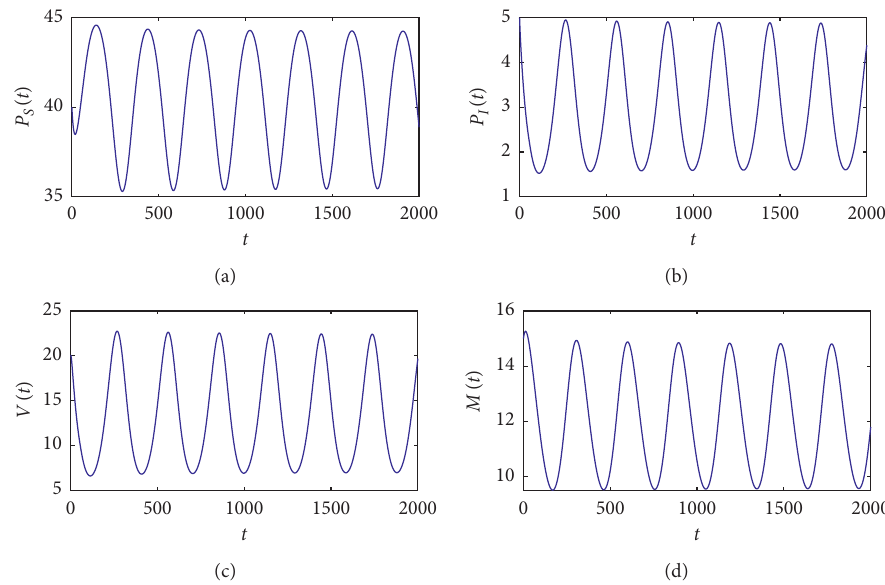
Figure 2: The time series of system (3) when α � 0 . 95and τ � 53 > τ 0